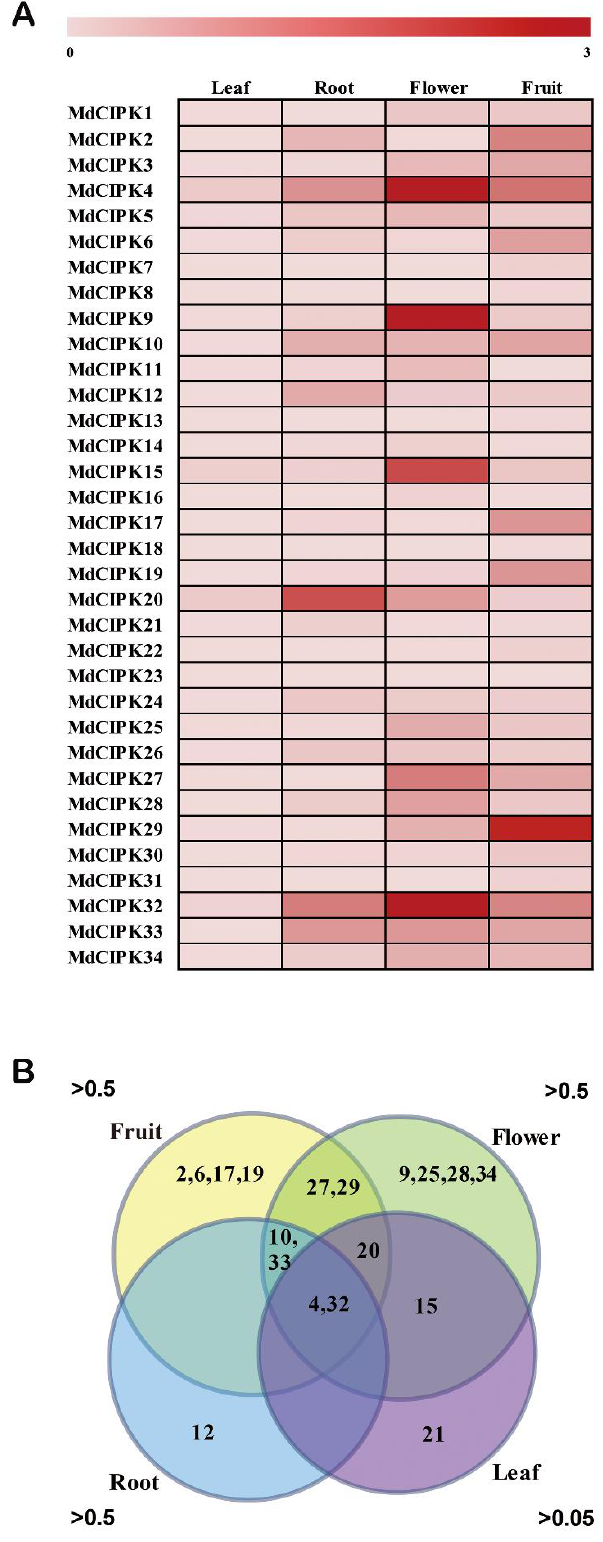
Figure 5. Expression patterns of apple CIPK genes in different tissues. Heat map of the 34 MdCIPK genes expression patterns in different apple tissues ( A ) and Venn diagram of differentially expressed gene sets, the numbers in each section represented MdCIPK genes ( B ). Three replicates were performed for each organ.